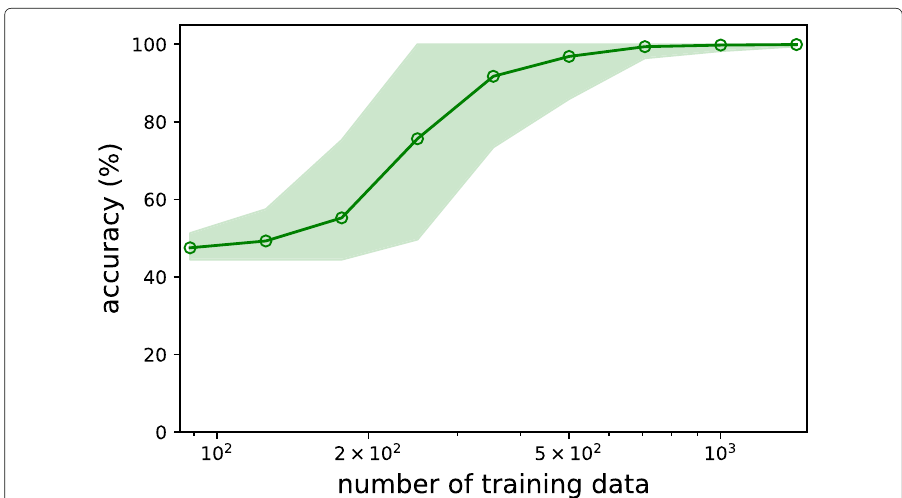
Fig. 7 Accuracy of reconstruction versus the size of training data. The amount of training data is ranging from about 10 2 to 10 3 with each sampling evolving for T = 100 time steps. The results are obtained on CML model with 10 nodes and the network topology is random 4-regular graphs. We set s = 0.2 and r = 3.6 to generate chaotic